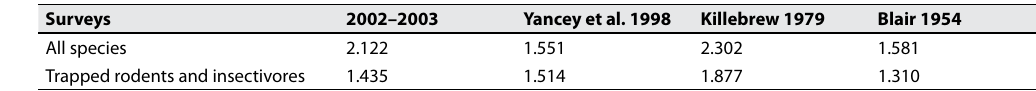
Table 5. Simpson Index (SI) expressed as a negative logarithm for all mammalian species, and small mammals (rodents and insectivores) trapped in the four studies discussed in this paper.